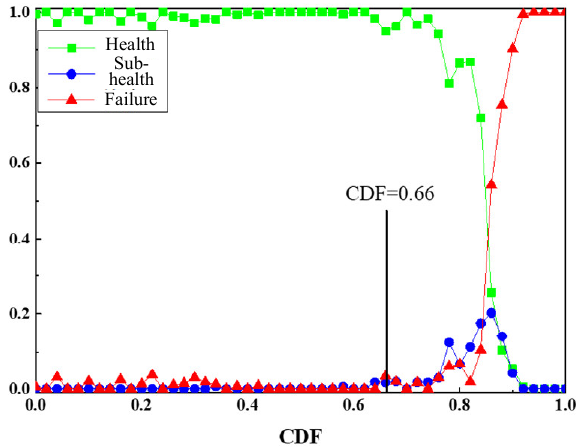
Figure 7. Probability change of transformer state diagnosis under different CDF values.